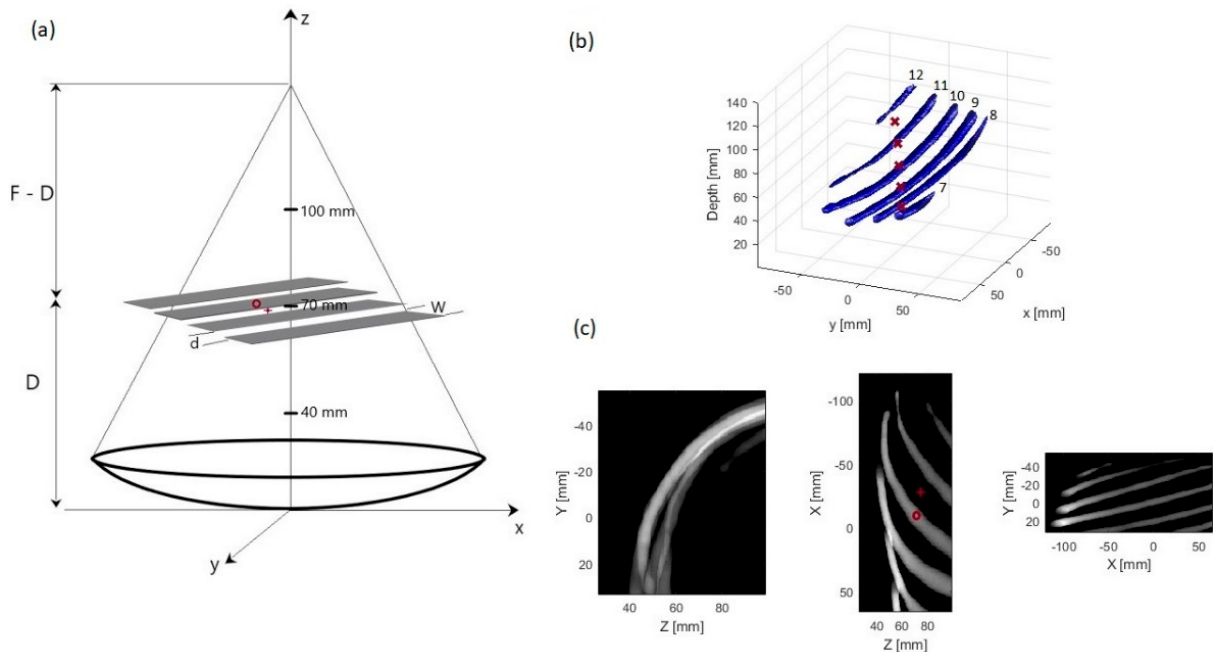
Figure 2. ( a ) Sketch of the geometric representation of the idealized rib cage and the transducer for the case when the ribs are positioned at a depth of 70 mm from the array center and the array axis passes through the center of one of the ribs, ( b ) 3D model of the patient-specific rib cage showing ribs 7–12. Five different depths of the 3D model used in the simulation are marked ( × ), ( c ) 2D slices of the rib cage model. (D: depth of the ribs plane from the array center, d: edge–edge spacing of the ribs, W: width of a rib, F: focal length of the array, o: center of a rib, +: center of intercostal spacing).